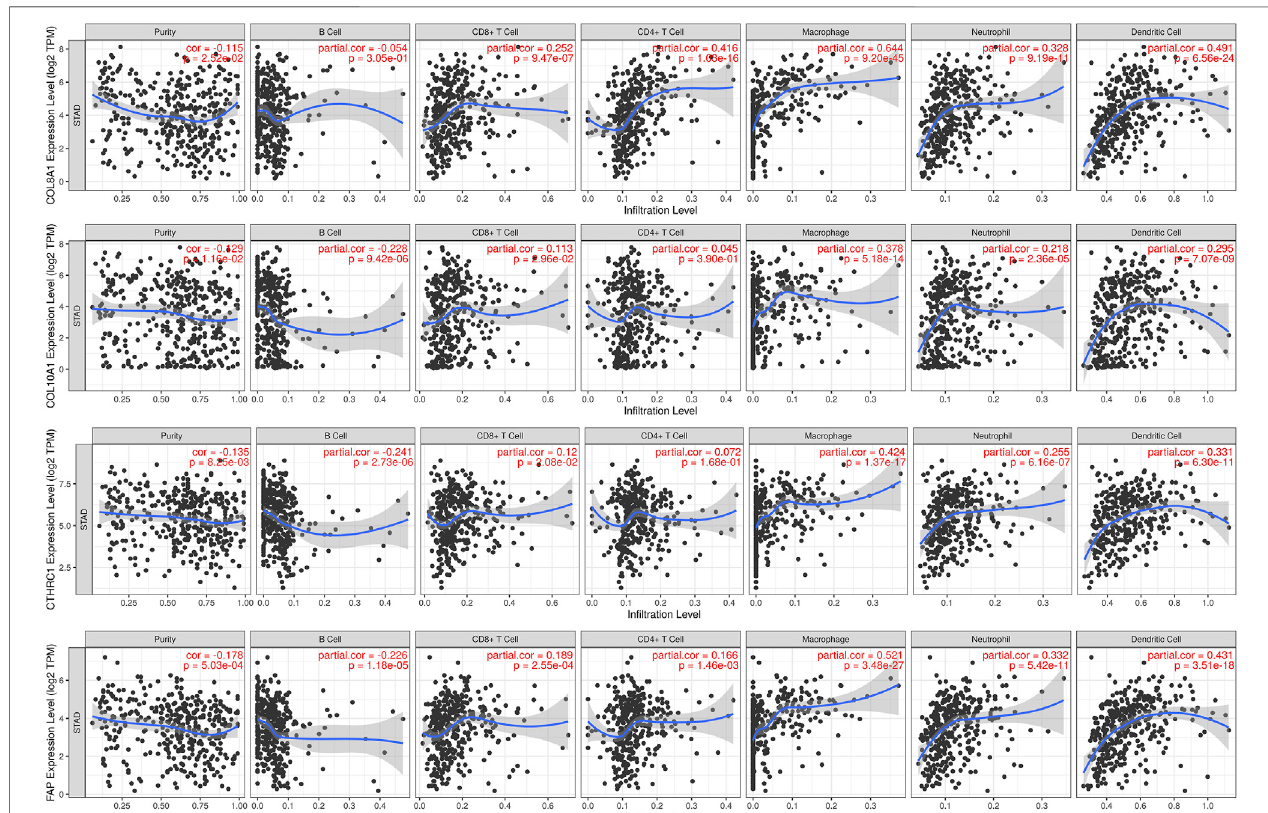
FIGURE 9 | Correlations between COL8A1, COL10A1, CTHRC1, and FAP and immune cell in fi ltration in gastric cancer (TIMER).